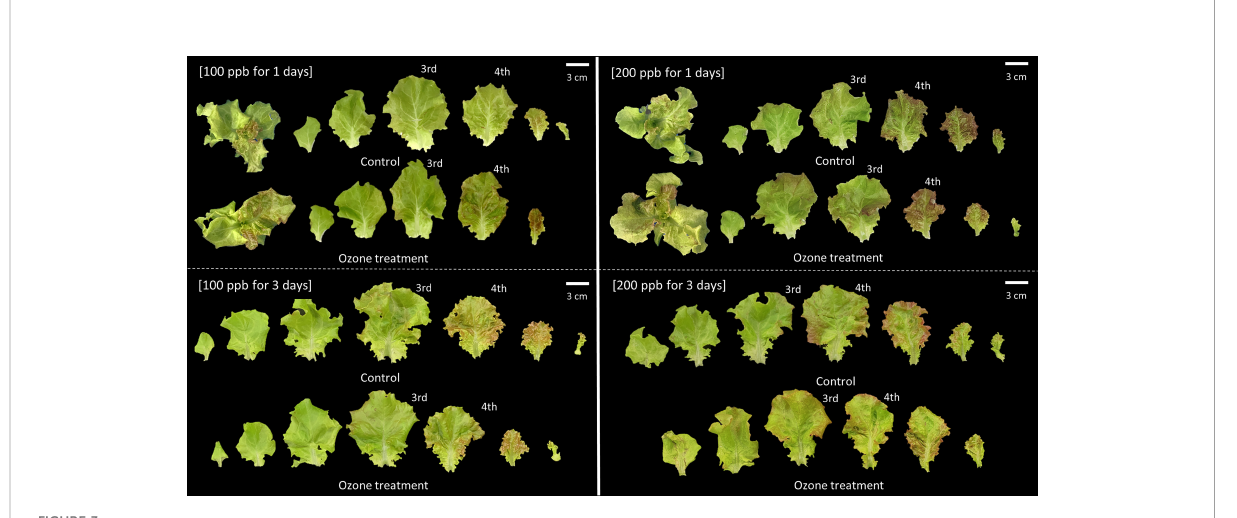
FIGURE 3 Red leaf lettuce plants exposed to 100 and 200 ppb ozone for 72